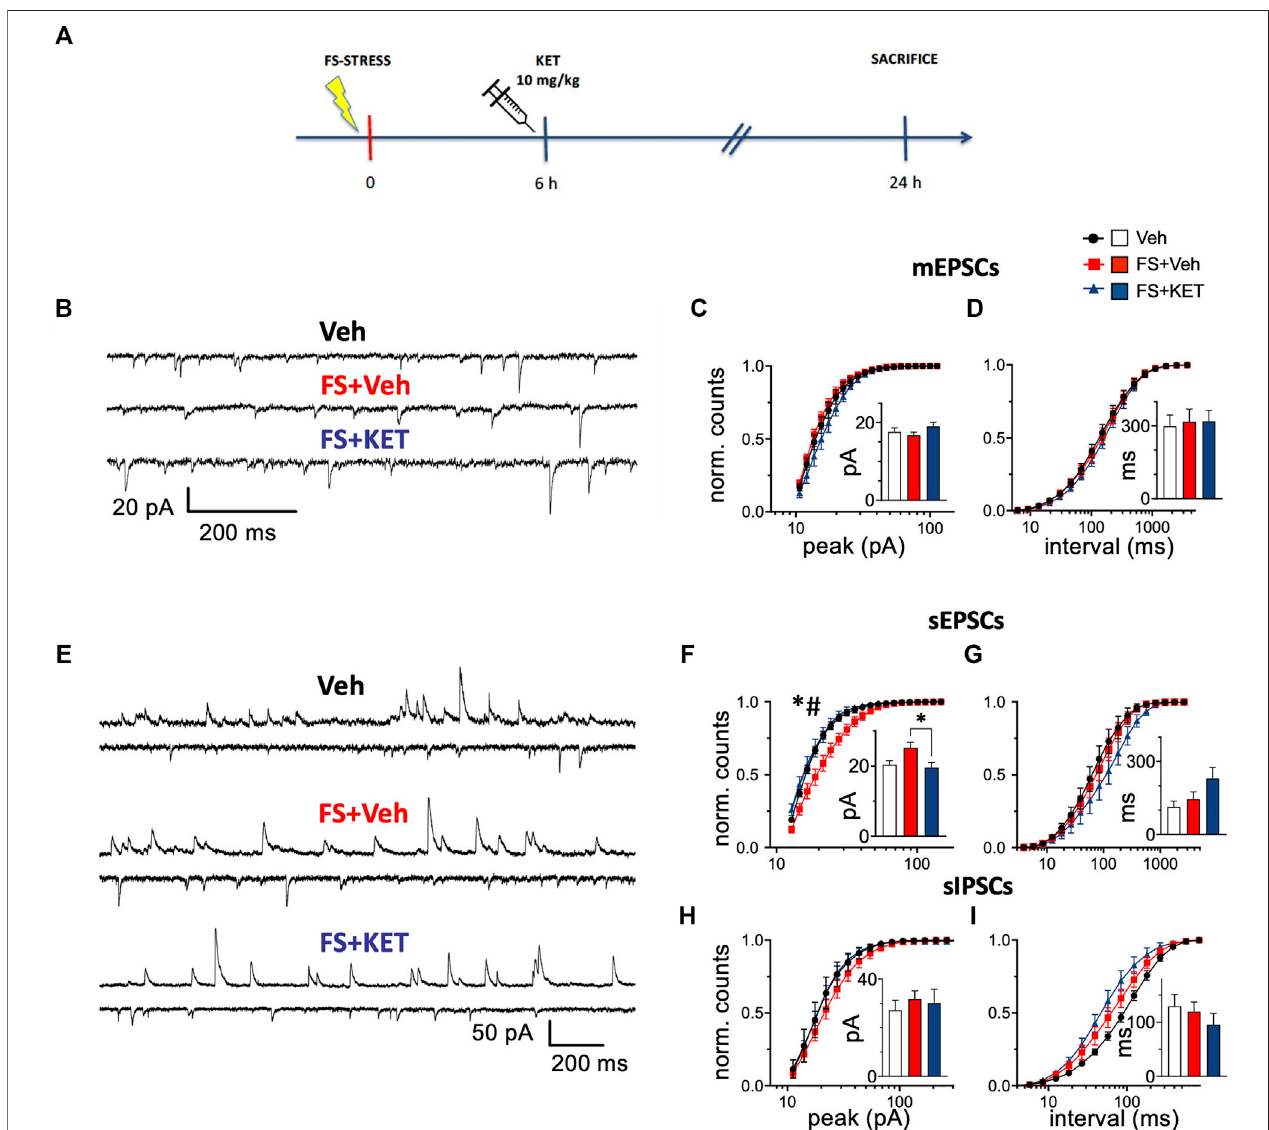
FIGURE 2 | Miniature and spontaneous synaptic transmission. (A) Experimental plan timeline. Rats were injected with saline (Veh), subjected to acute FS, and injectedwithsaline6 hafterstress(FS+Veh)orsubjectedtoacuteFSandinjectedwithketamine6 hafterstress(FS+KET).Alltheanimalsweresacri fi ced24 hafterFS beginning. (B – D) Miniature excitatory PSCs [mEPSCs, tetrodotoxin (TTX) 1 μ M, picrotoxin 0.1 mM, and strychnine 1 μ M] recorded with patch-clamp in putative pyramidalneuronswithinPL-PFClayersII – III. (B) RepresentativetracesfromVeh(uppertrace),FS+Veh(middletrace),andFS+KET(bottomtrace)cells( − 60 mV). NormalizedbinnedcumulativedistributionsofmEPSCpeakamplitudes (C) andinter-eventintervals (D) averagedacrossVeh(14cells),FS+Veh(11cells),andFS+KET (9cells).Bargraphinsets:meansoftheaveragemEPSCpeakamplitude (C) andinter-eventinterval (D) . (E – I) SpontaneousexcitatoryandinhibitoryPSCs(sEPSCsand sIPSCs respectively) PSCs. (E) Representative paired traces from Veh (top pair), FS + Veh (middle pair), and FS + KET (bottom pair) cells. In each pair, the upper and lower traces show sIPSCs (+3 mV) and sEPSCs ( − 58 mV), respectively. Normalized binned cumulative distributions of peak amplitudes (F,H) and inter-event intervals (G,I) of sEPSCs (F,G) and sIPSCs (H,I) averaged in Veh (sEPSCs: six cells; sIPSCs: fi ve cells), FS + Veh (sEPSCs: six cells; sIPSCs: nine cells), and FS + KET (sEPSCs: sevencells;sIPSCs:eightcells).Bargraphinsets:meansoftheaveragepeakamplitude (F,H) andinter-eventinterval (G,I) ofsEPSCs (F,G) andsIPSCs (H,I) .Allthedata are expressed as means ± SEM (see main text for more details). Post-hoc tests: * p < 0.05, FS + Veh vs Veh; # p < 0.05, FS + KET vs FS +